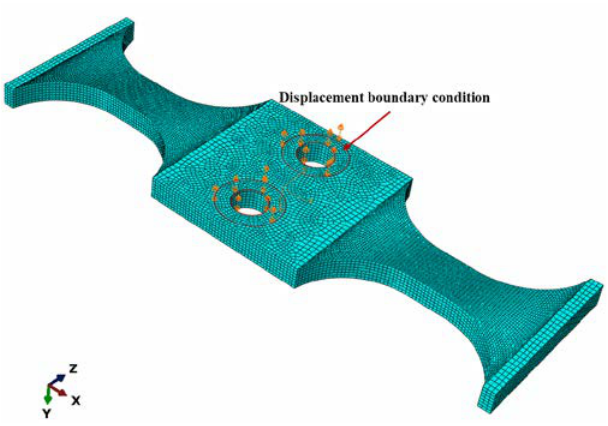
Figure 2. The finite element model of the specimen.